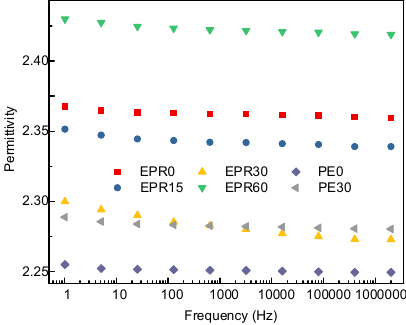
Figure 3. Relative permittivity of different fluorinated samples.